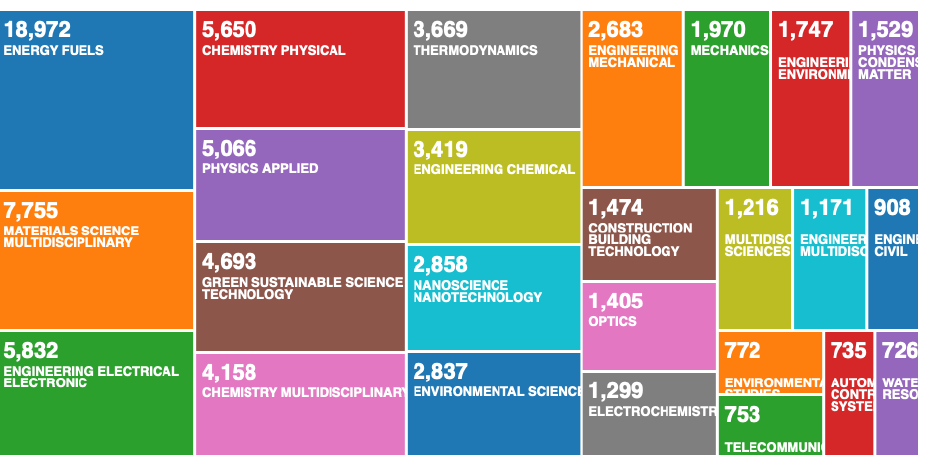
Figure 6. Publications according to WOS research categories for solar energy research (between 1900 and 2020).